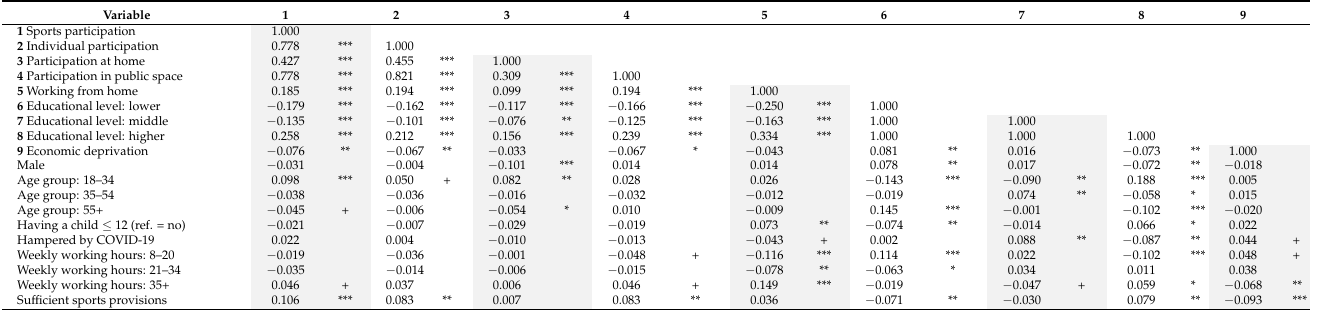
Table 2. Pearson correlations.